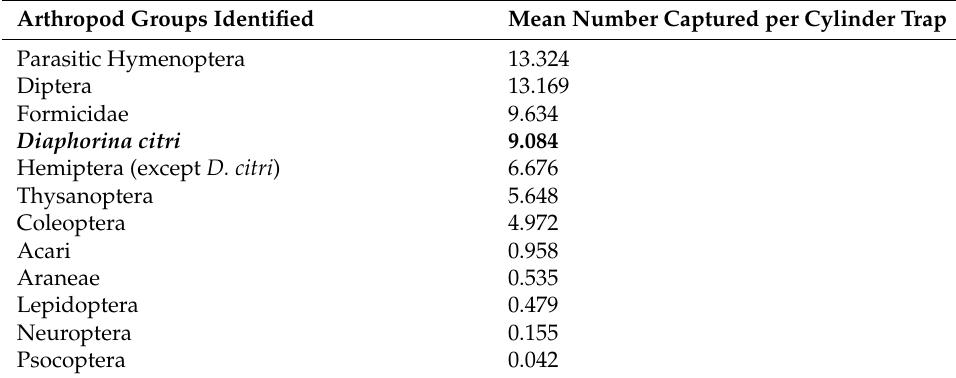
Figure 7. Trap evaluation in citrus groves in Temecula, CA. The mean number of ACPs captured per trap during a six-week evaluation period is shown with standard error bars. Two types of traps were deployed ( n = 16 for cylinder traps and n = 8 for sticky cards). The use of similar letters indicates a lack of significant difference in the ACP capture rates. Field evaluations in Temecula were conducted from March 2019 through February 2020. Table 1. List of various arthropods collected in the cylinder